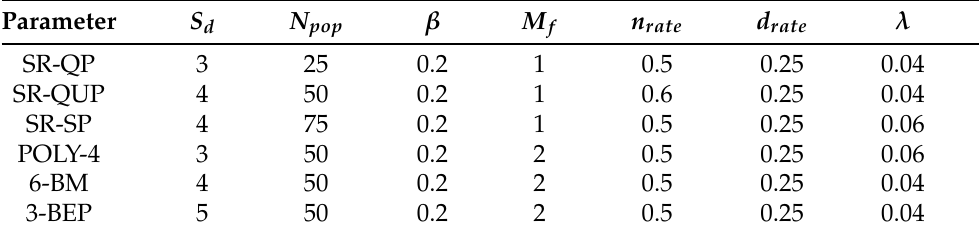
Table 1. Standard values of ISPLS parameters for the test problems.